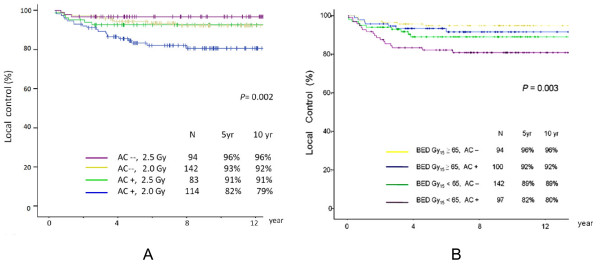
Local control rate according fraction size, tumor BED 15, AC involvement. a. fraction size, together with AC involvement. b. tumor BED G15, together with AC involvement. Abbreviations: AC: anterior commissure  tumor BED Gy15: tumor biologically effective dose  N: patients numbers  AC-- : absence of AC involvement   AC+: presence of AC involvement .